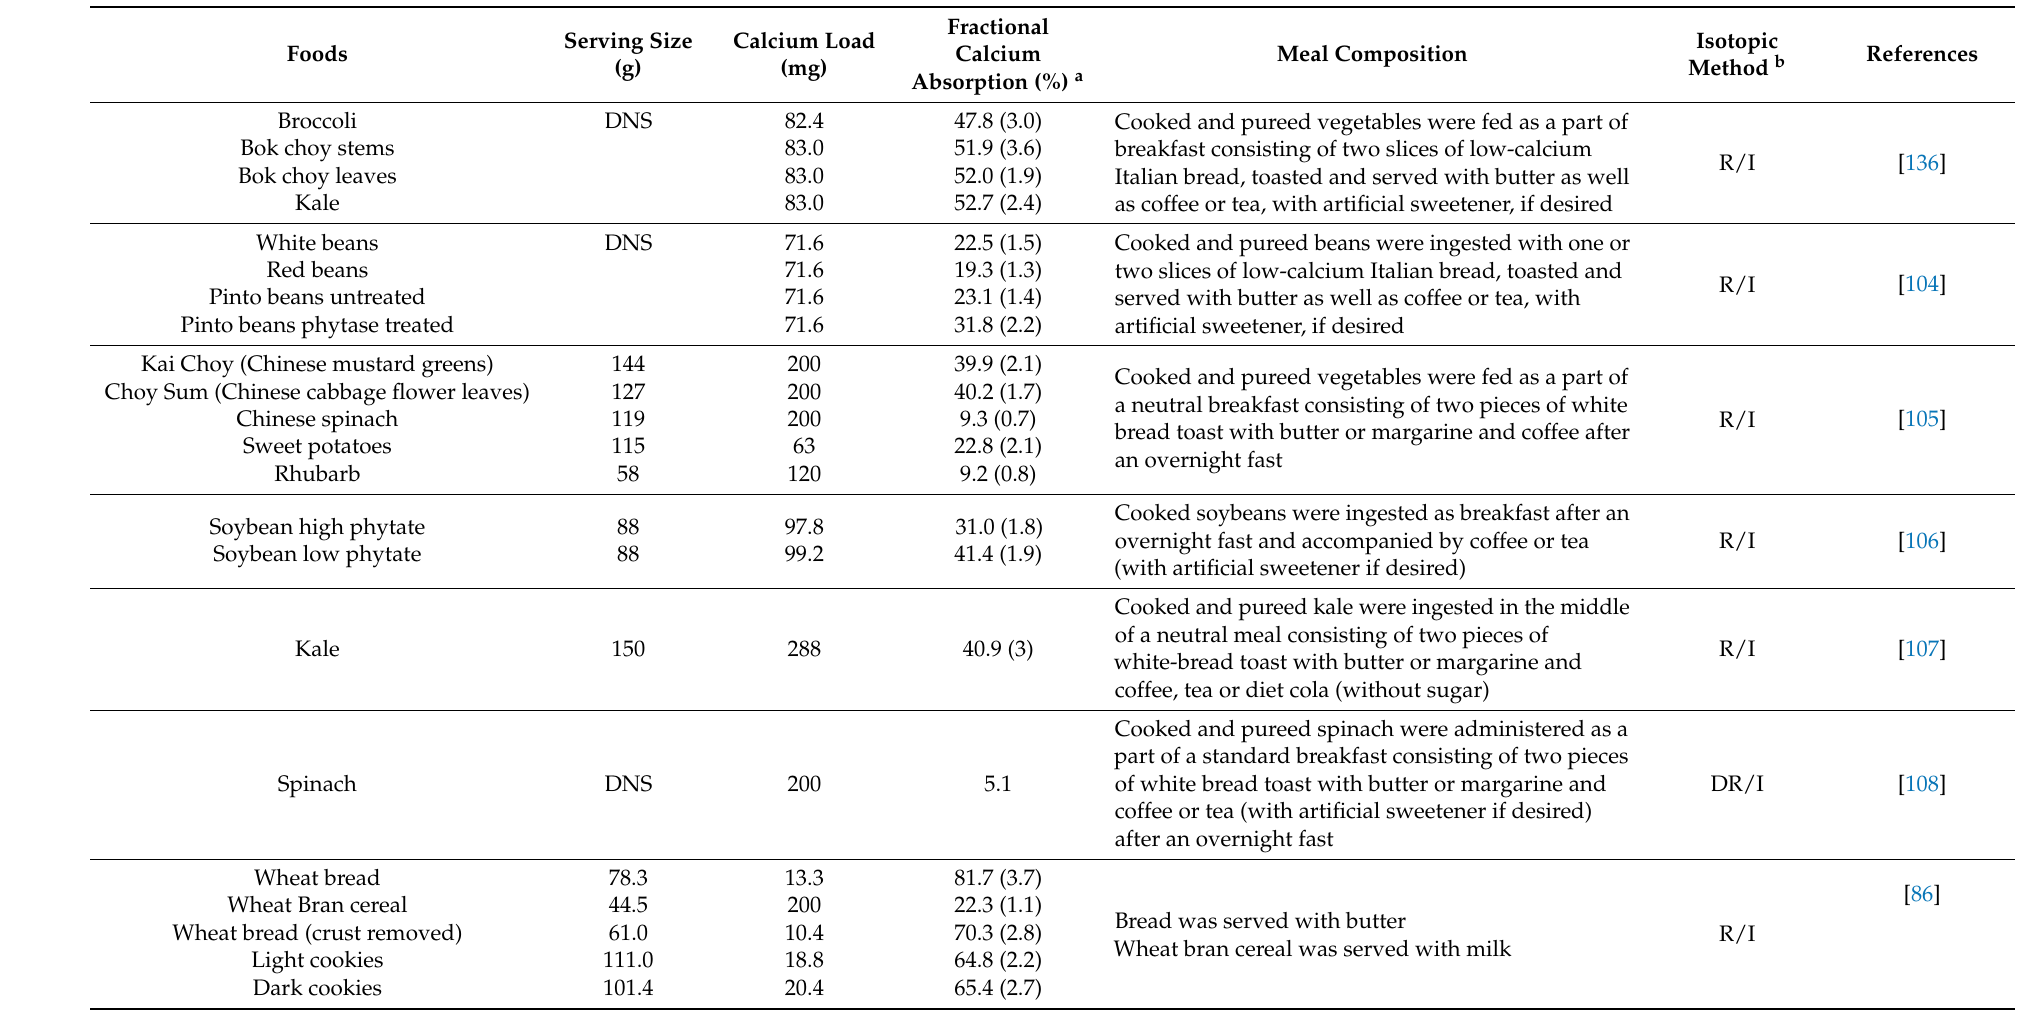
Table 5. Fractional absorption of calcium from non-dairy food